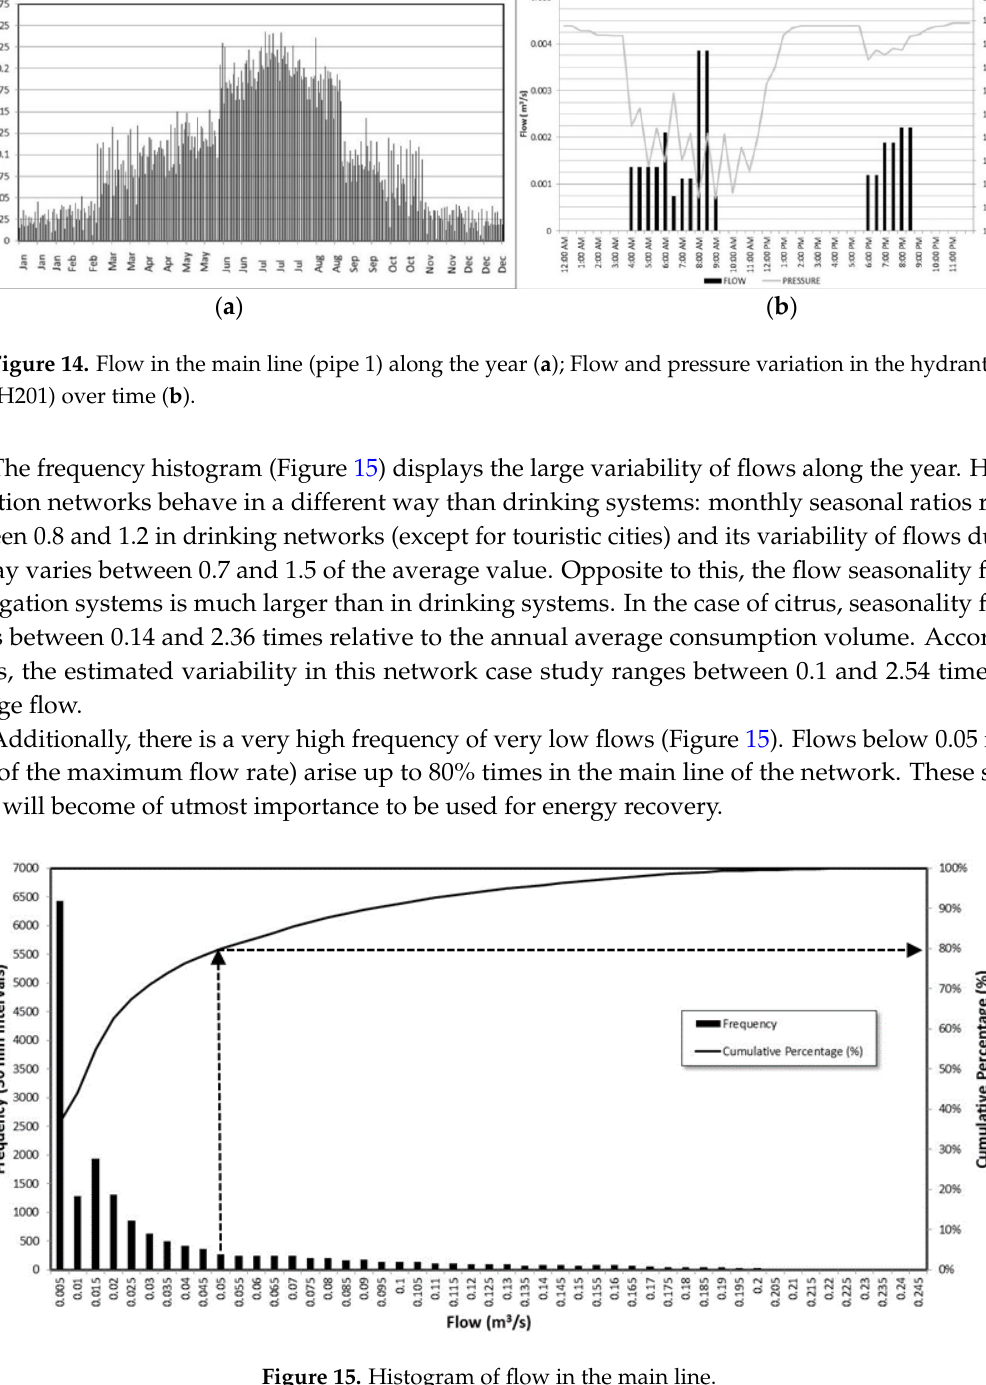
16 of 25 Figure 13. Identification of hydrants in the irrigation network.